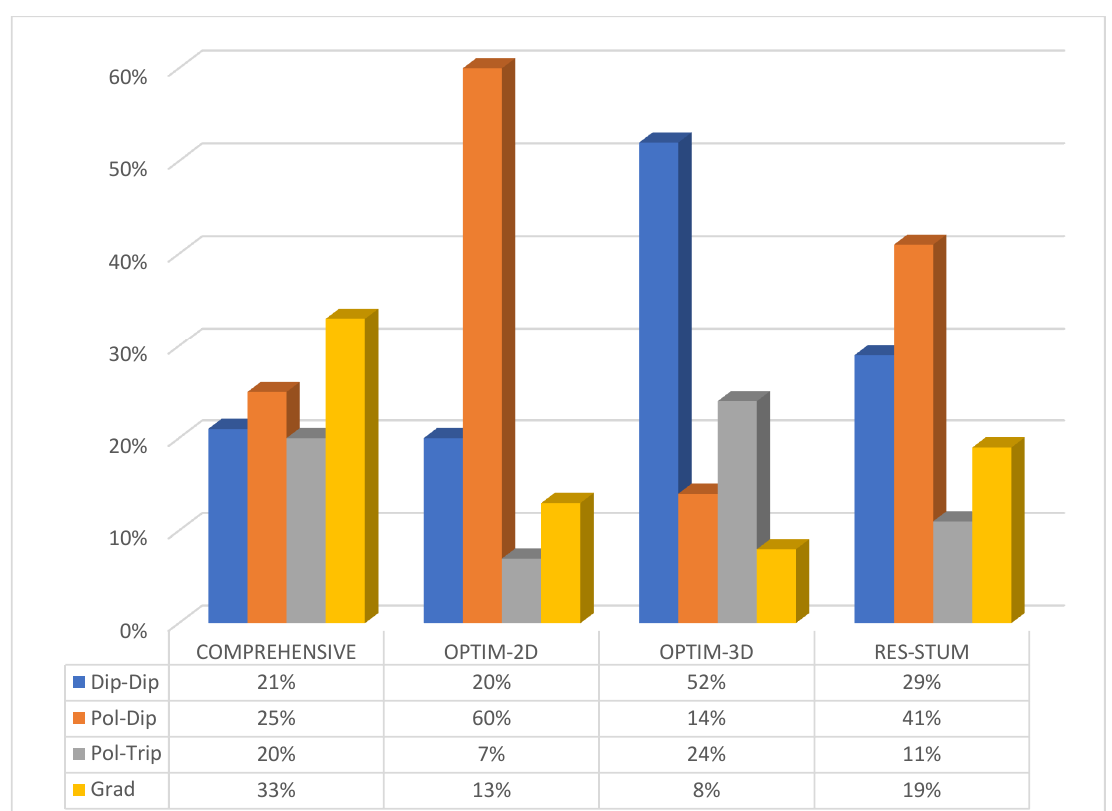
Table 2. Participation of protocols used at data.